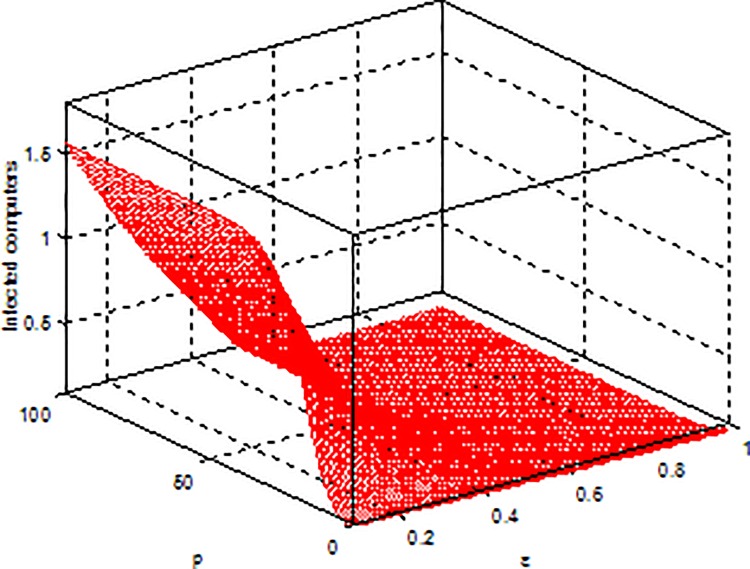
Dynamical behaviors of every system variable with parametersε-I(t).